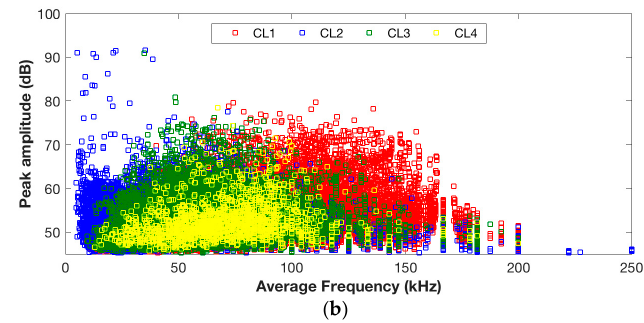
Figure 6. Clustering results: the partition of AE signals on time domain features. ( a ) Clustering results on average frequency vs MARSE; ( b ) Clustering results on average frequency vs. peak amplitude.